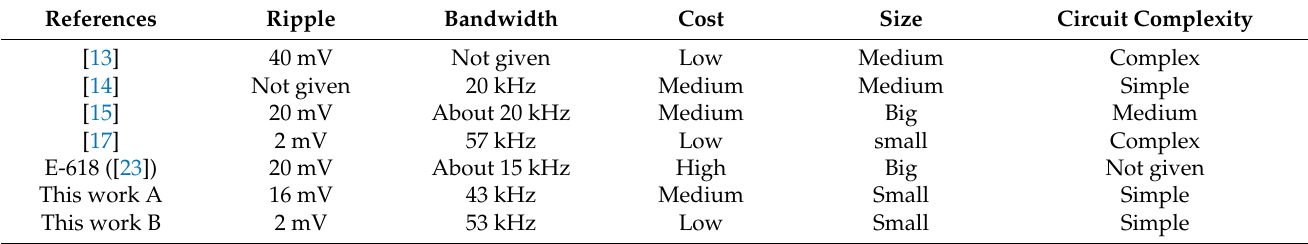
Table 3. Comparisons between the power amplifiers proposed in this paper and some